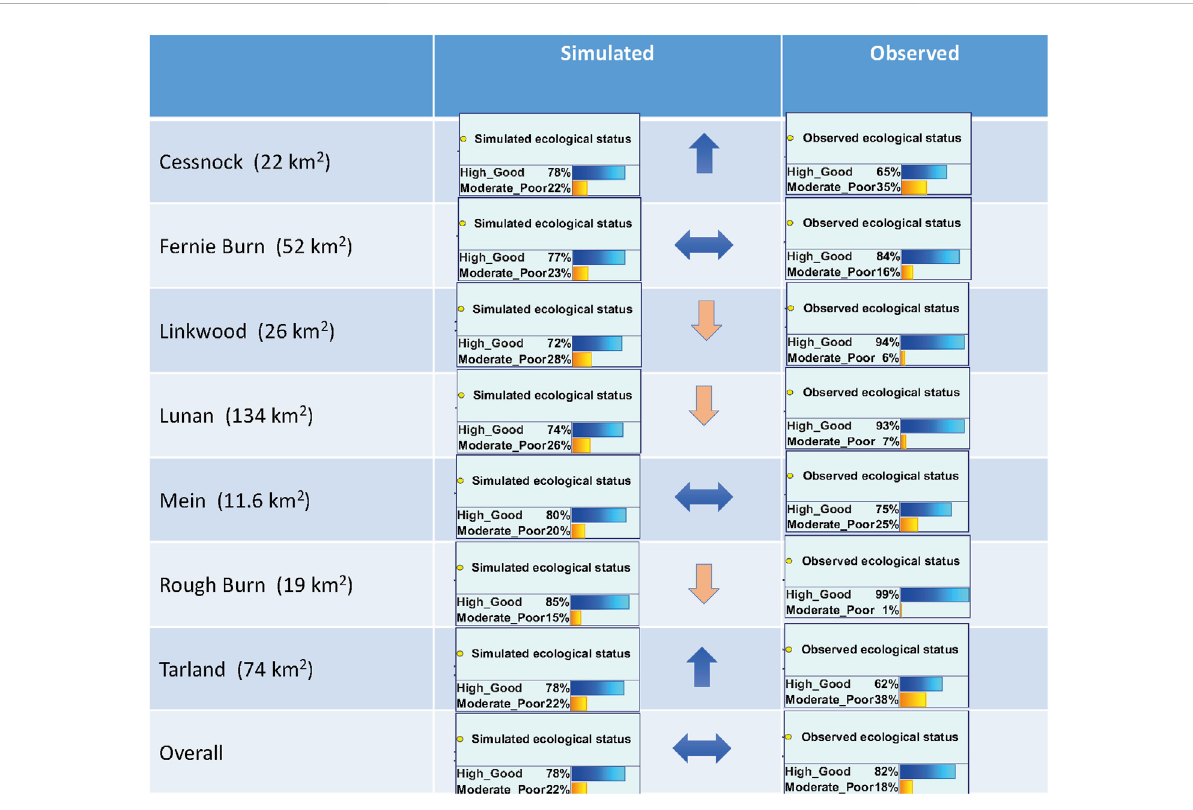
FIGURE 4 Simulated probability of achieving GES compared against observed SRP concentrations at the catchment outlet. Horizontal arrows indicate simulations that are within 10% of observed SRP values. Upward and downward arrows indicate instances where model simulations depart from the observed probabilities by > 10%. “ Overall ” indicates average simulations marginalised across the seven study